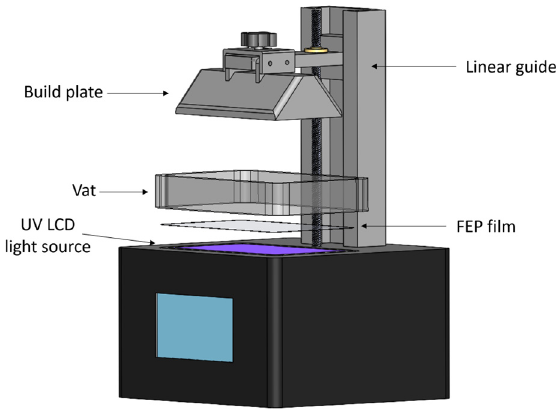
Figure 2. Main elements of an LCD 3D printer.